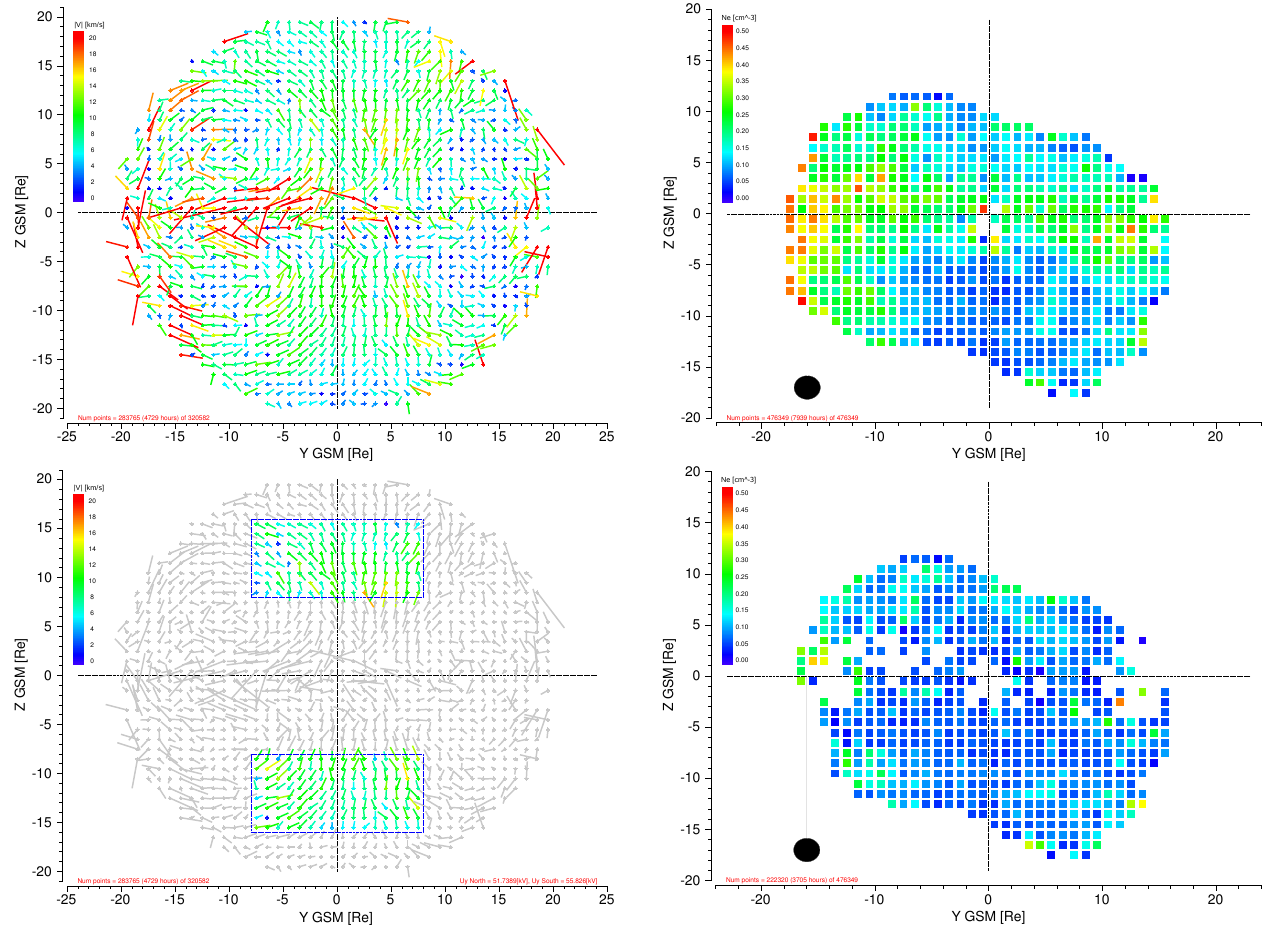
Fig. 1. YZ GSM view of the convection and density. Top left: Average convection for the full data set. The arrows show the convection strength (color coded) and direction of the convection in the ZY GSM plane. Top right: electron density (color coded) for the full set. Bottom: Similar, but only including records we define as lobe (see Sect. 4.1). Convection data are mapped into an YZ plane at X= − 10 R E , whereas the density plots show averages of densities collected between X= − 6 R E to X= − 21 R E